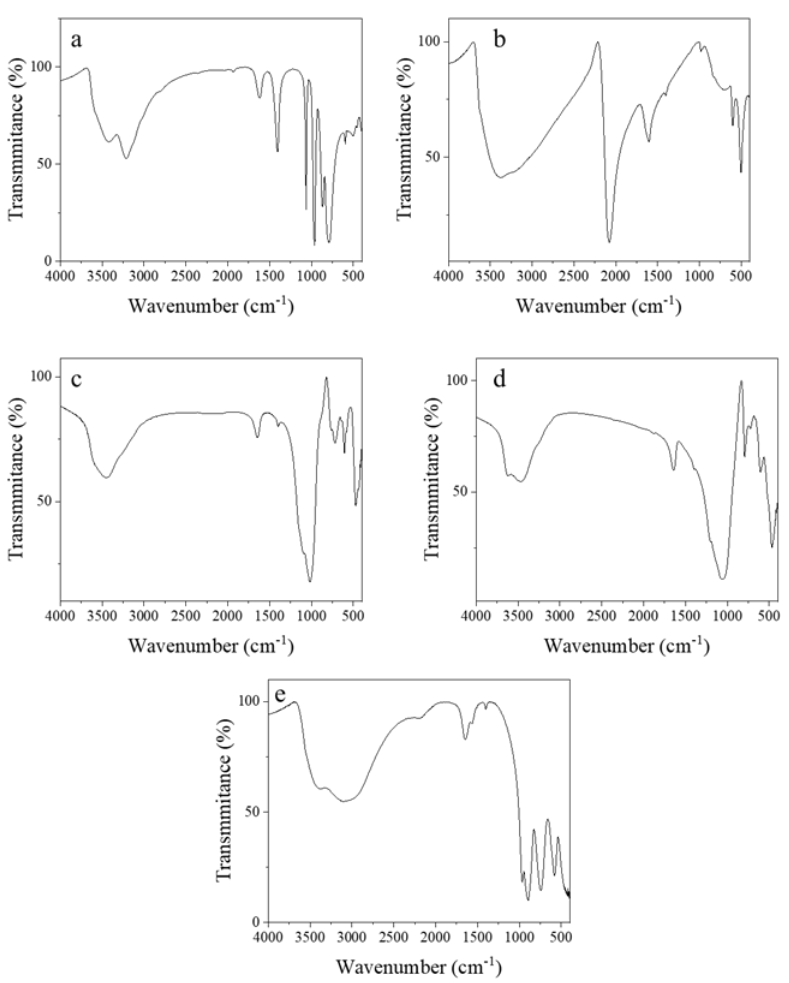
Figure 2. FT-IR spectra of adsorbents ( a ). AMP ( b ). PB ( c ). CBT ( d ). CPT ( e ). CST.